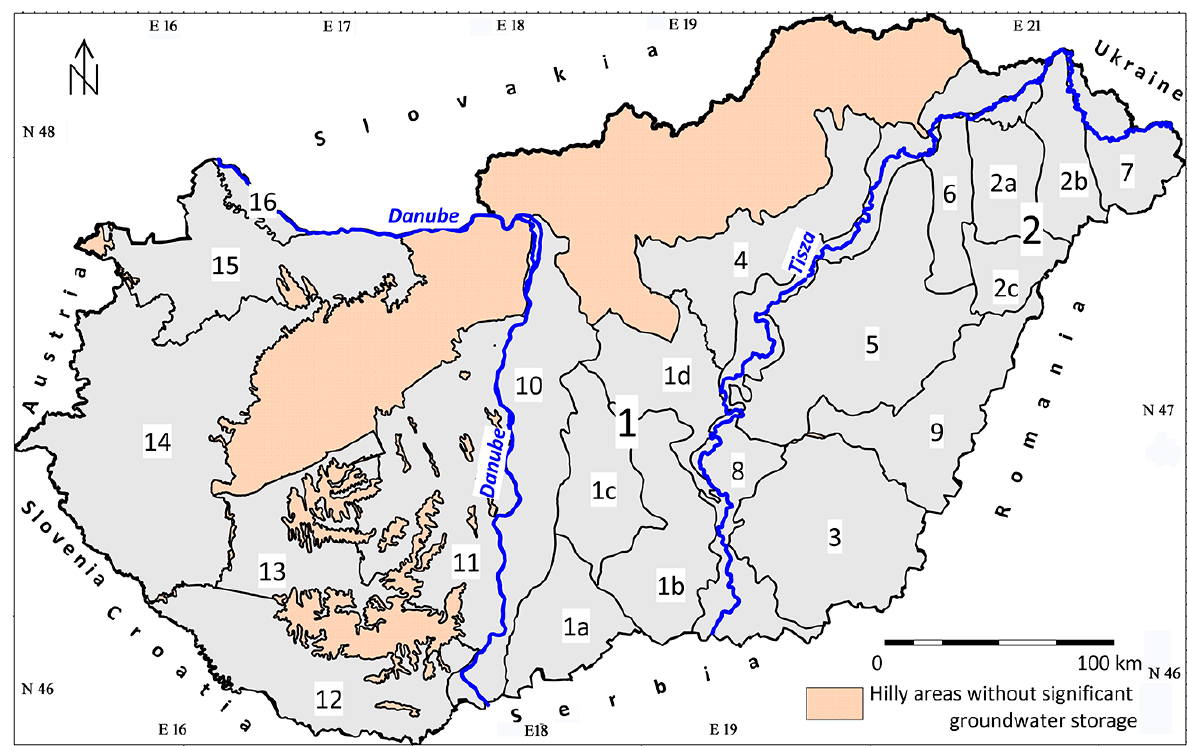
Figure 1. Areas included in the shallow groundwater resource assessment in Hungary Regions and micro-regions: 1: Danube–Tisza Interfluve; 2: Nyírség; 3: Maros–Körös Interfluve; 4: North Periphery of Great Hungarian Plain; 5: Central Tisza Plain; 6: Hajdúság; 7: Upper Tisza Plain; 8: Tisza Valley; 9: Berettyó–Körös Plain; 10: Danubian Plain; 11: